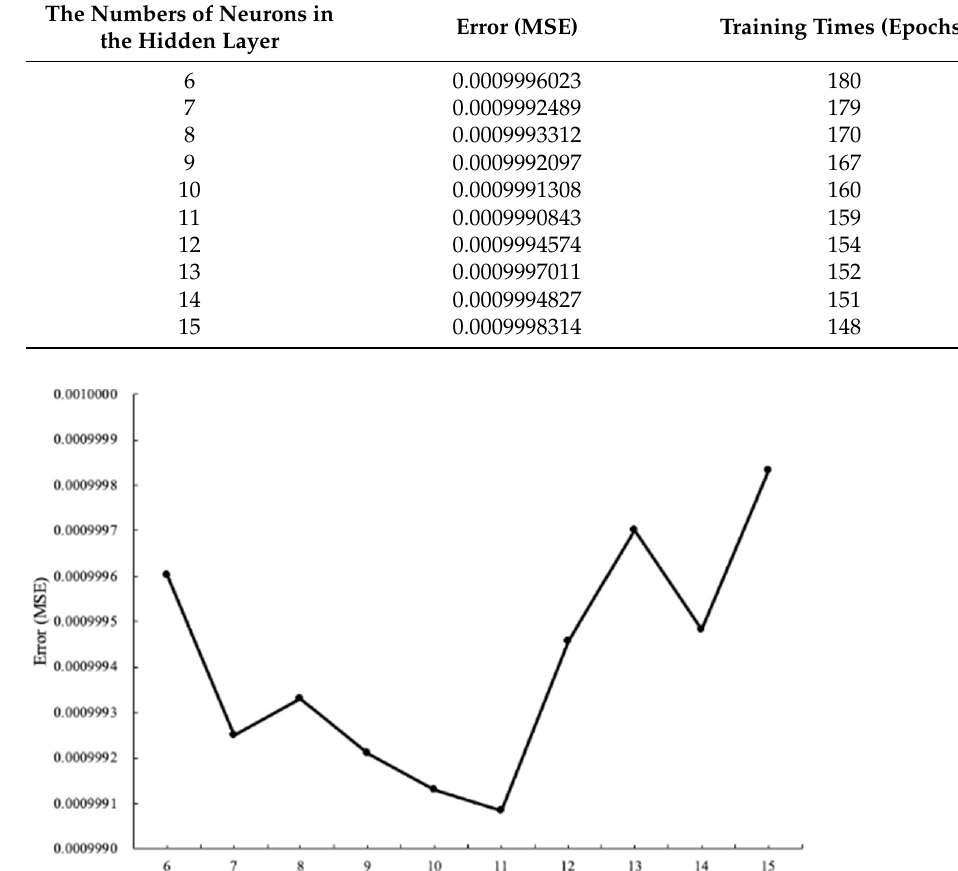
Figure 3. Model performance comparison for different numbers of neurons in the hidden layer.